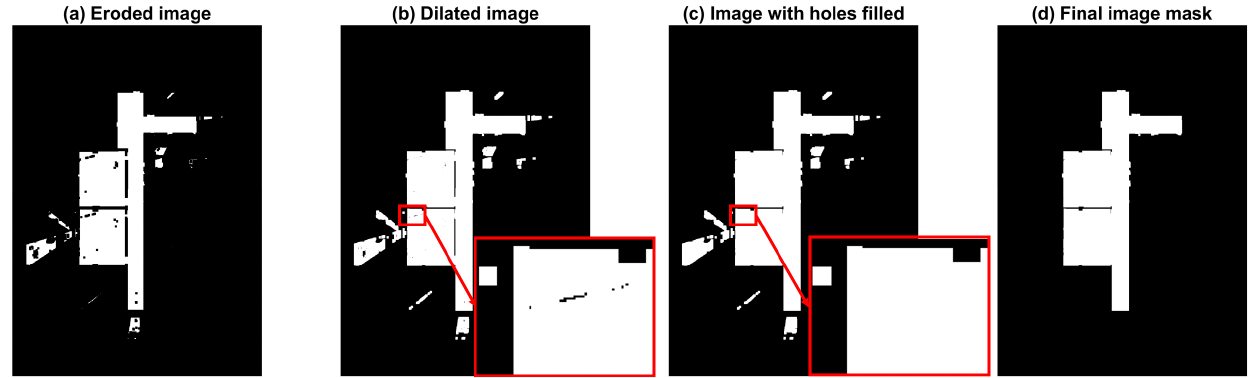
Figure 4. The updated binary masks in each data processing stage: ( a ) erosion, ( b ) dilation, ( c ) hole filling, and ( d ) connec- tivity analysis for extracting the largest object.